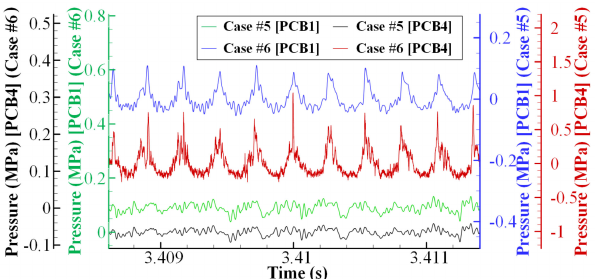
Figure 14. Pressure distribution along the streamwise direction.